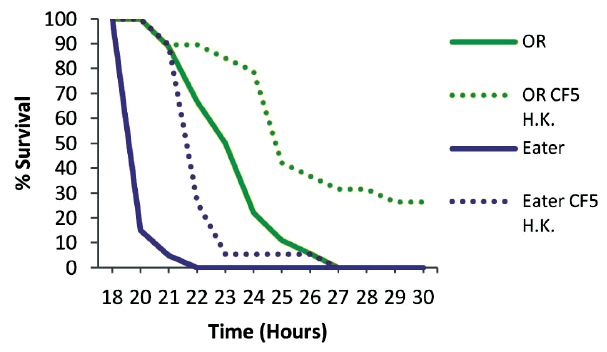
Figure 4. Survival kinetics of wt and cellular response deficient flies 2 days post priming with heat-killed Pseudomonas aeruginosa CF5. Eater mutant and wild type Oregon R flies (OR) were primed two days prior to PA14 injection to investigate the role of phagocytosis in immune priming. Eater deficient flies were more susceptible to infection than wild type flies (P<0.0001) in the absence of priming. Nevertheless Eater mutants survived longer when primed indicating additional immune responses of the host at 2 days post priming. n=18–20 flies per